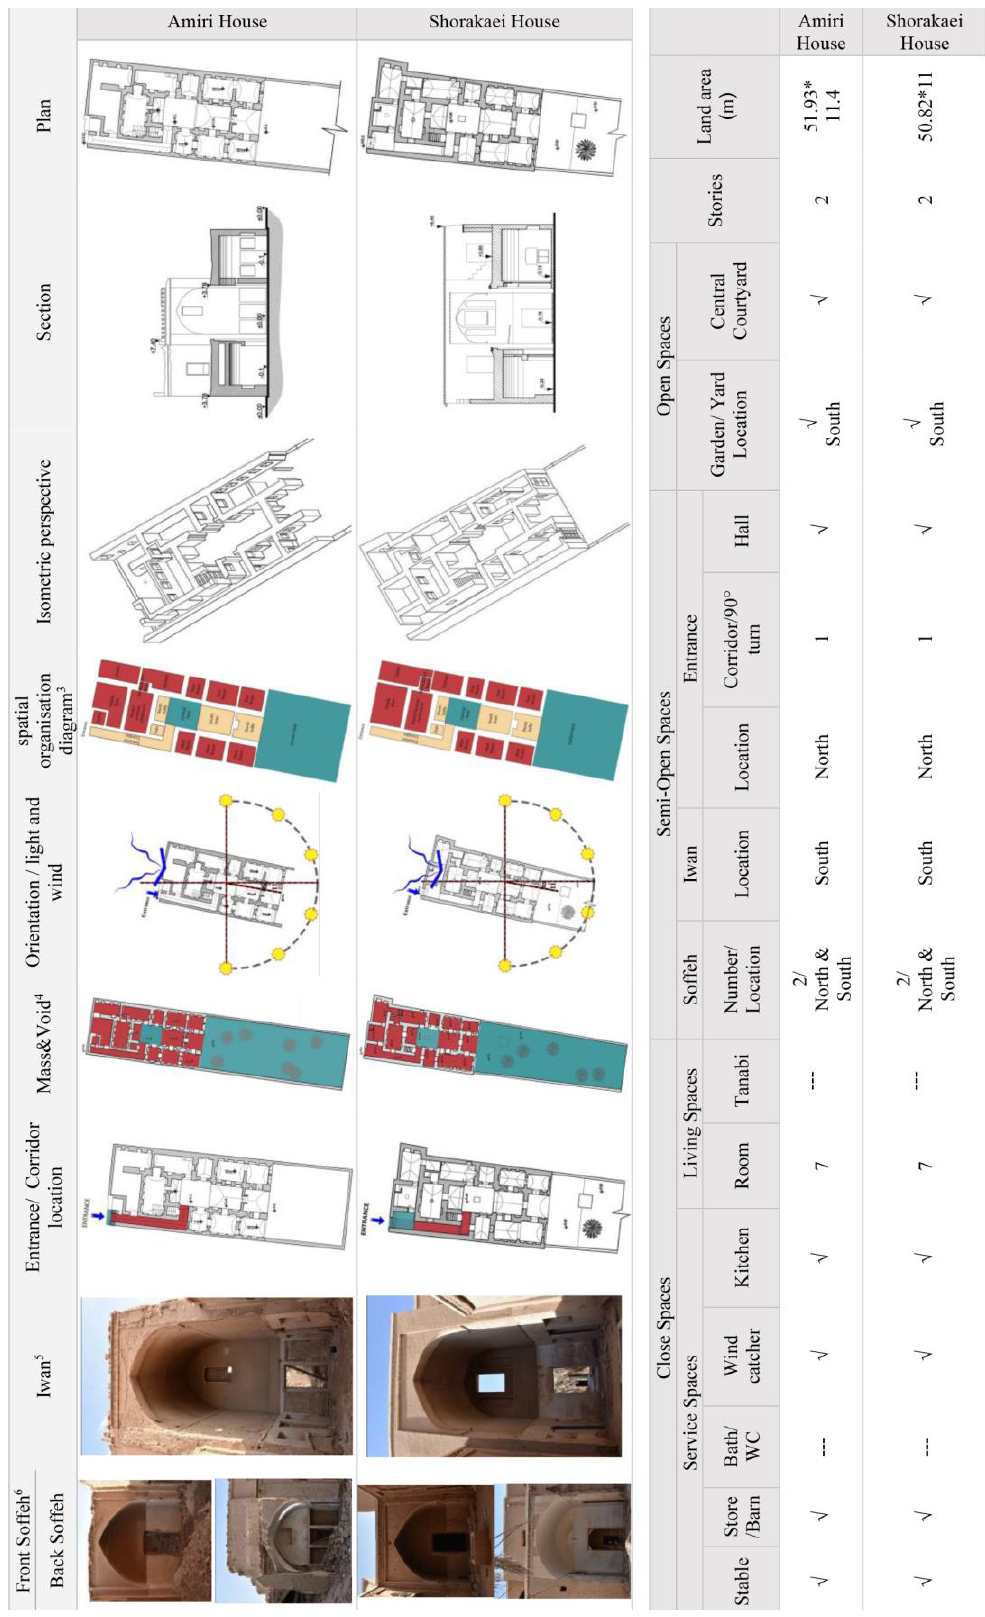
Table 2. Main Spatial and Functional characteristics of Amiri and Shorakaei Houses. Reference: